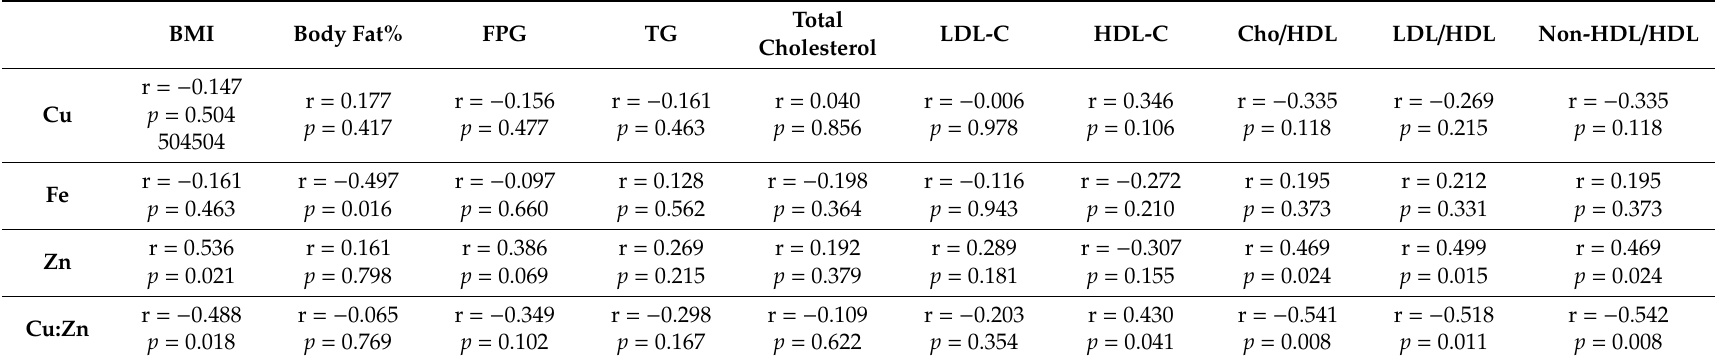
Table 2. Correlations between plasma levels of trace elements (Zn, Fe, Cu) and Cu:Zn ratio with anthropometrical and biochemical parameters in study subjects.